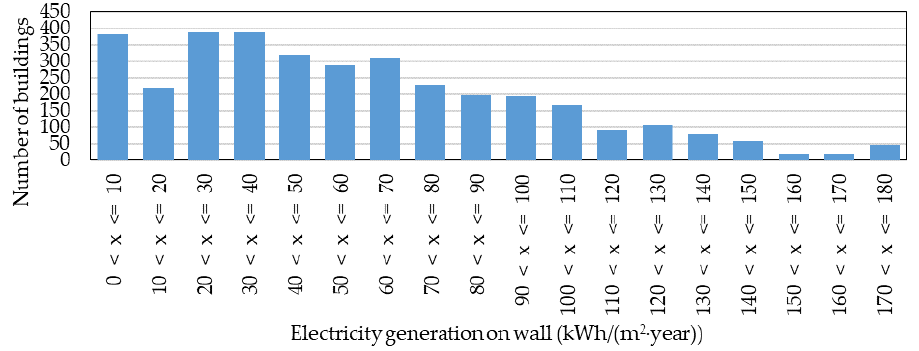
Figure 9. Histogram of annual electricity generation.